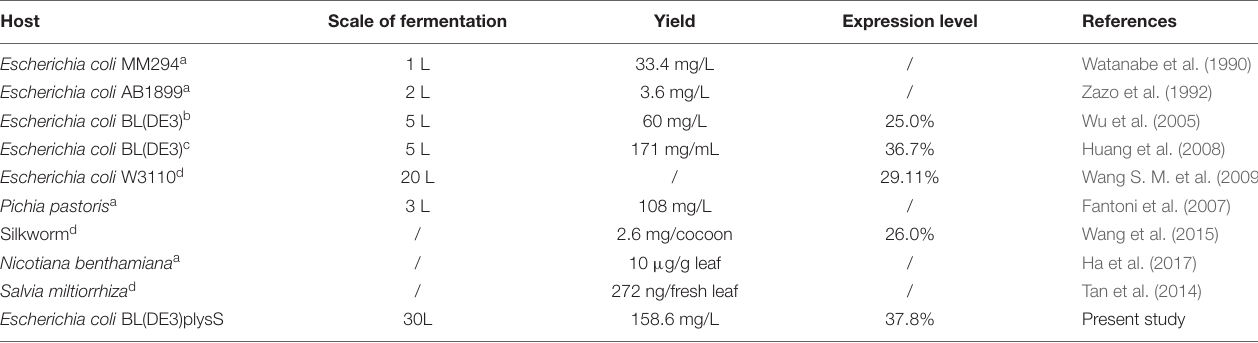
TABLE 4 | Comparison of total productivity of rhaFGF in different hosts. Scale of fermentation Expression